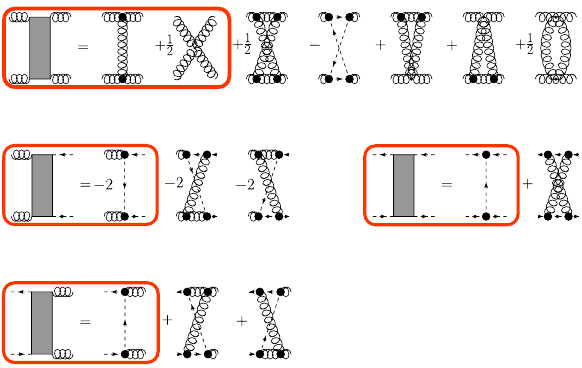
Fig. 2 Interaction kernels from the three-loop 3PI effective action. All propagators are dressed; black disks represent dressed vertices. In our calculation, we include the diagrams inside the red rectangles. Details are discussed in the